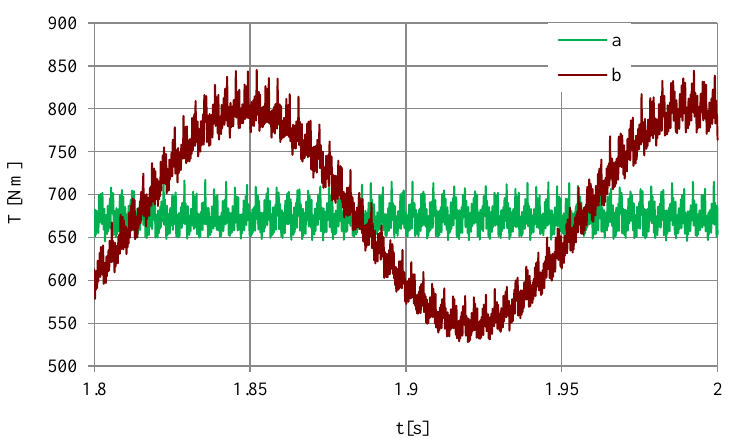
Figure 11. Computed torque waveform of motor 200-p2, supplied with (a) purely sinusoidal volt- age and (b) voltage containing interharmonic of frequency f ih = 57 Hz and the case of NMI.